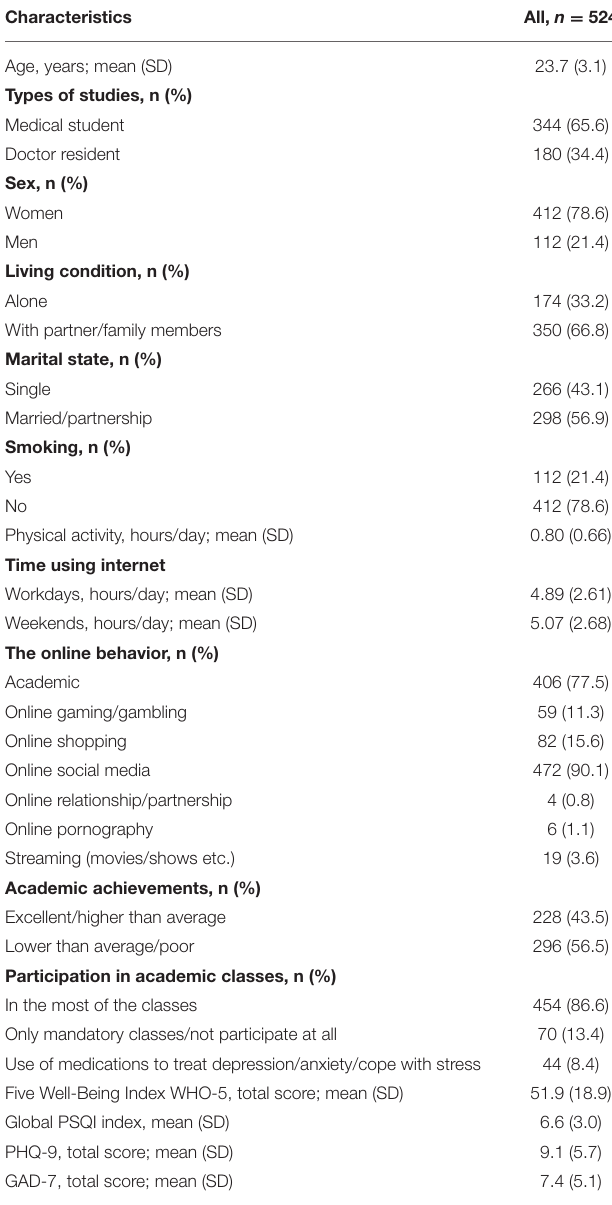
TABLE 1 | Sociodemographic characteristics and self-reported psychological assessments in study participants.